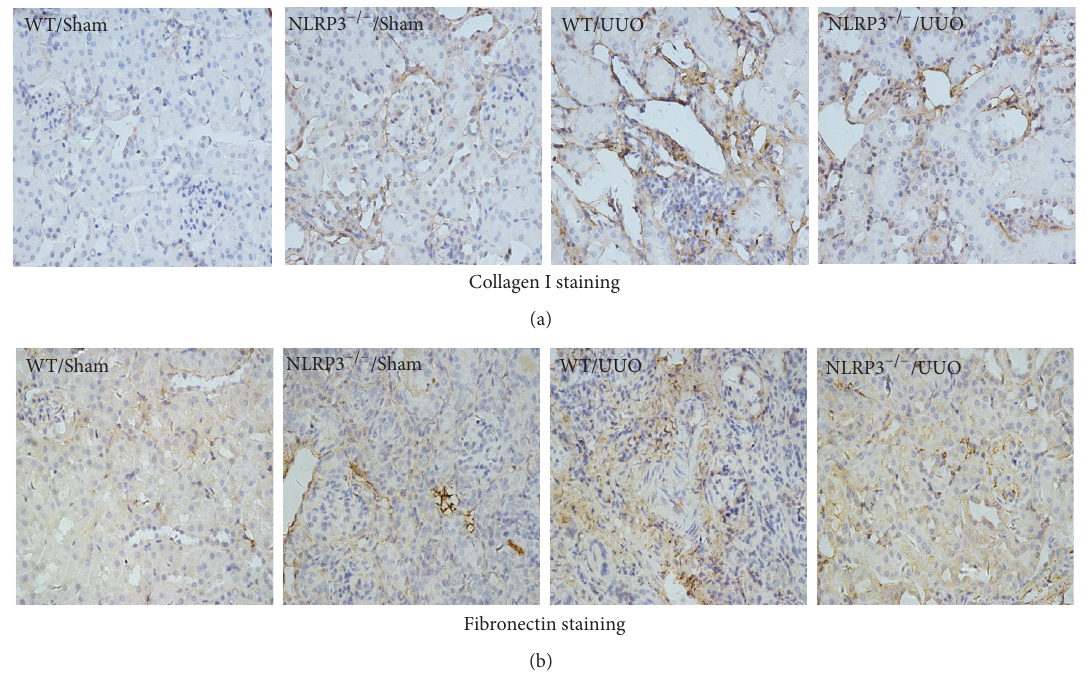
Figure 2: Immunohistochemical staining for deposition of collagen I ((a) magnification, × 400) and fibronection ((b), magnification, × 400) in kidney sections from different groups at day 14 after